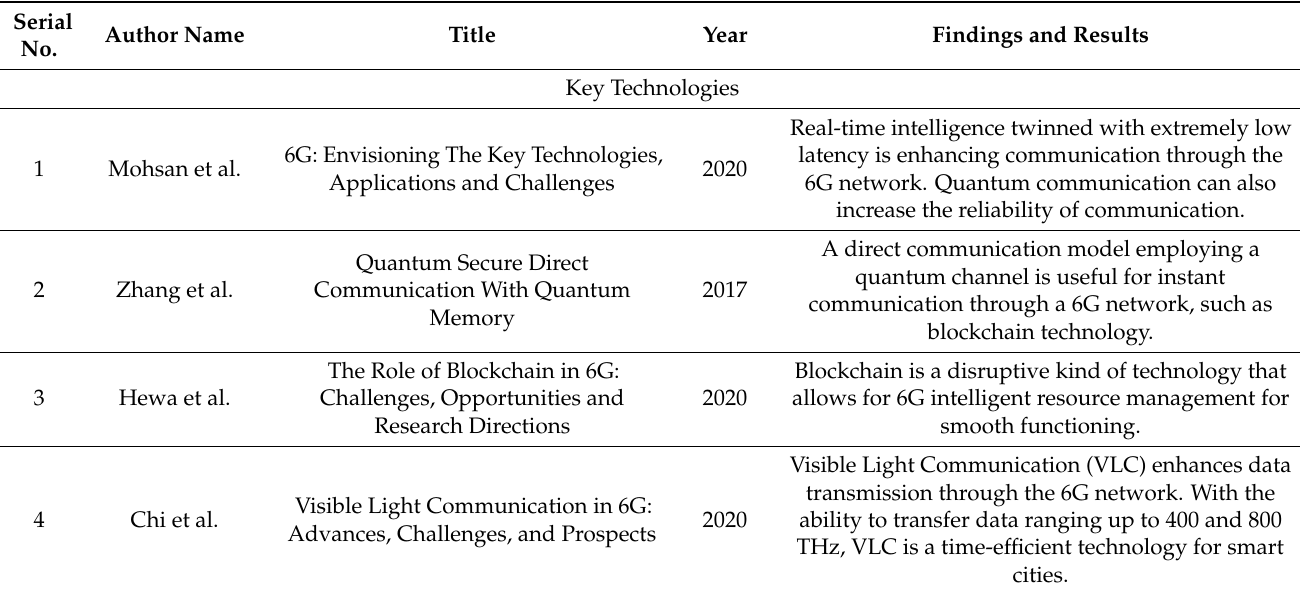
Table A1. Results of systematic literature